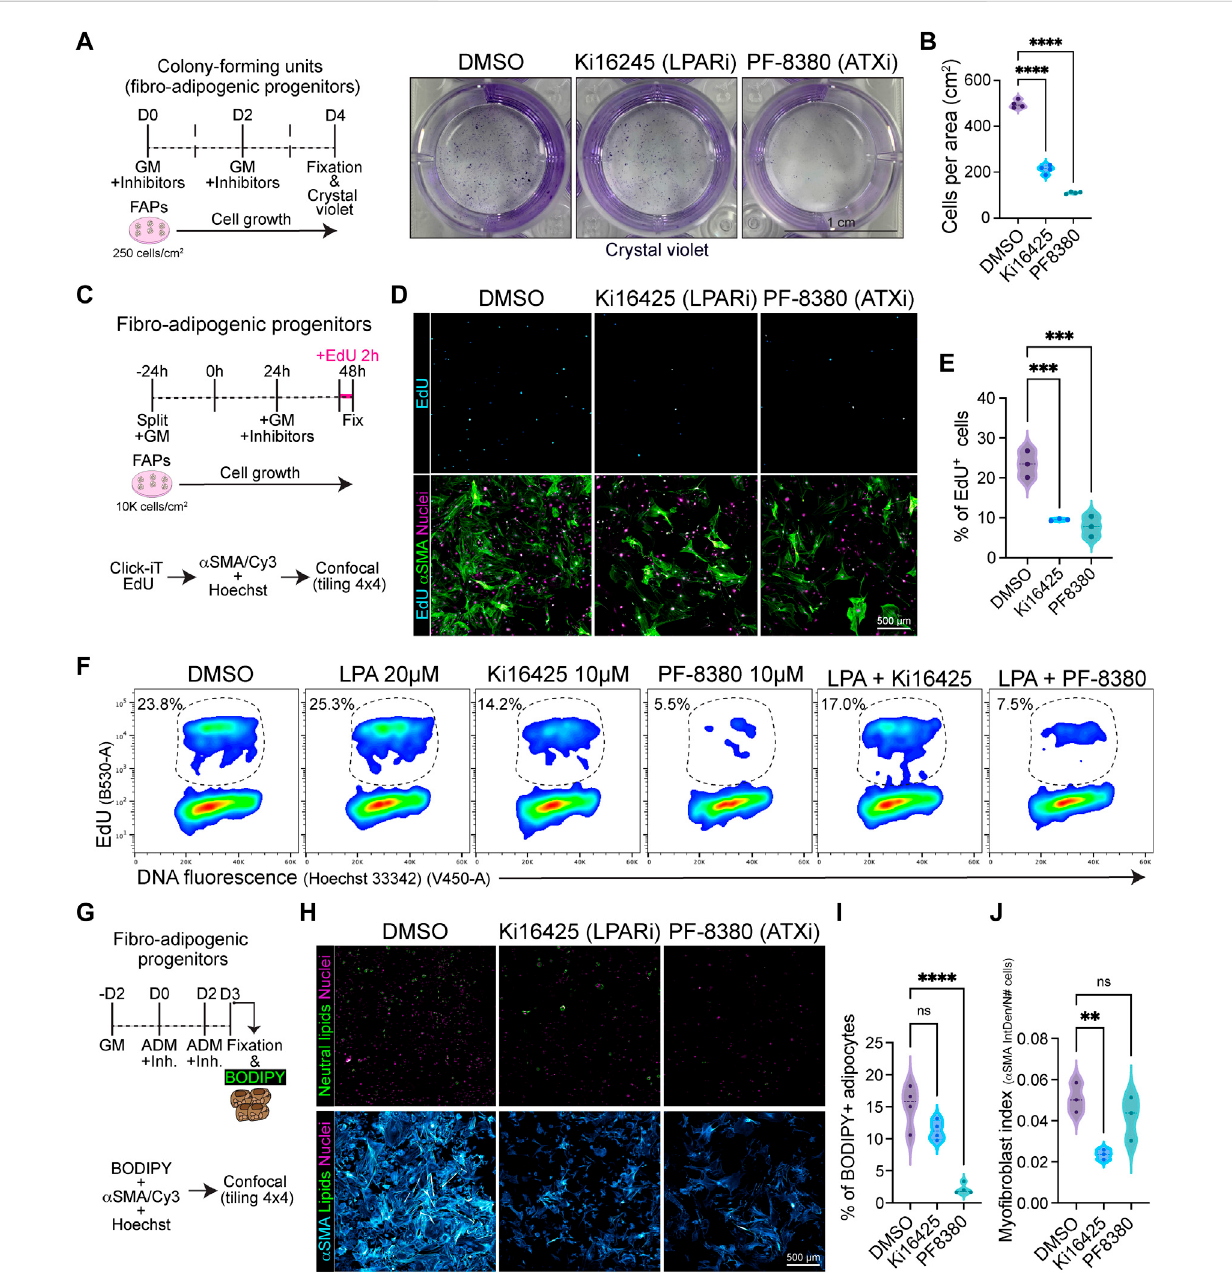
FIGURE 6 Pharmacological inhibition of LPA receptors and Autotaxin reduces fi bro-adipogenic progenitor cell growth and proliferation affecting their fi bro- fatty fate. (A) Outline of colony-forming units assay using muscle FAPs. Representative images of FAPs control-treated (DMSO) or treated with Ki16245 (10 μ M, LPAR1/3 inhibitor) and PF-8380 (10 μ M, ATX inhibitor) as shown, and then stained with Crystal Violet. Scale bar: 1 cm. (B) Quanti fi cation of the number of cells per area as shown in (A) from four independent experiments. **** p < 0.0001 by one-way ANOVA with Tukey ’ s multiple comparison post-test; n = 4. (C) EdU assay outline. (D) Representativelaser confocal images ofFAPs after the different treatments [DMSO as control, Ki16245(10 μ M) and PF-8380 (10 μ M)] at 24 h post treatment. EdU staining in shown in cyan hot, nuclear staining with Hoechst in magenta, and α SMA is shown in light green.Scalebar:500 μ m. (E) Quanti fi cationofthe%ofEdUlabelledcellsat24 hposttreatments.** p < 0.001byone-wayANOVAwithTukey ’ spost-test; n = 3. (F) Flow cytometry determination of EdU labelled cells in combination with DNA fl uorescence at 24 h of treatments. (G) Outline of neutral lipid staining assay in muscle FAPs treated with adipogenic differentiation media (ADM). (H) Representative laser confocal images of FAPs after the different treatments [DMSO as control, Ki16245 (10 μ M) and PF-8380 (10 μ M)] at day 3 post treatment. BODIPY staining is shown in light green, nuclear staining in magenta, and α SMA in cyan hot. Scale bar 500 μ m. (I) Quanti fi cation of the % of BODIPY labelled cells. **** p < 0.0001 by one-way ANOVA with Tukey ’ s multiple comparison post-test; n = 4. (J) Myo fi broblast index of α SMA labelled cells. ** p < 0.0021 by one-way ANOVA with Tukey ’ s multiple comparison post-test; n =